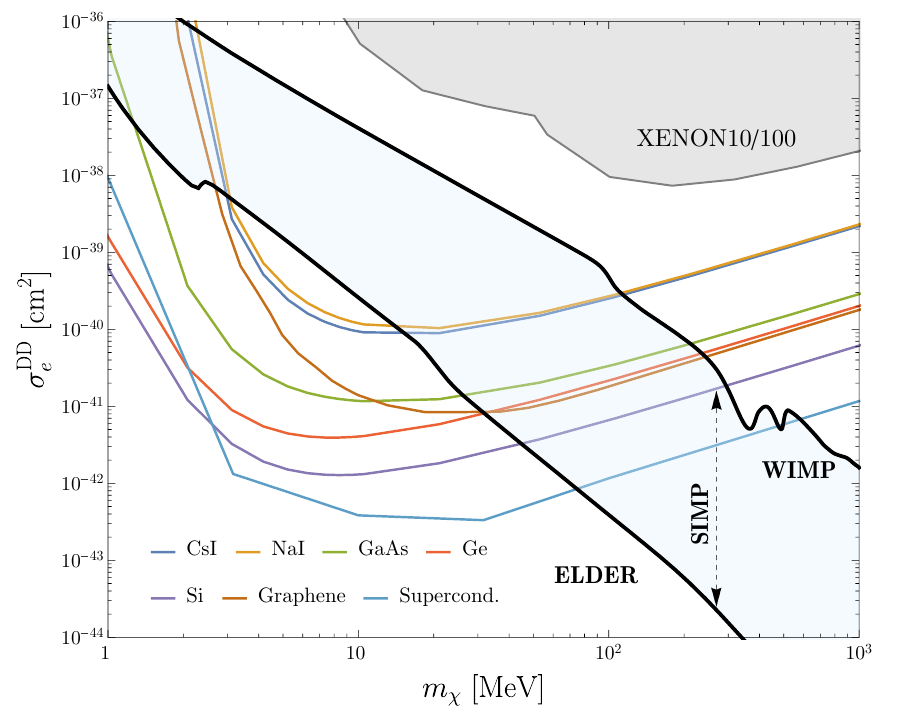
Figure 3 . Direct detection cross section, (cid:27) DD , predicted in the ELDER, WIMP and SIMP scenar- e ios with a dark photon portal. For comparison, also shown are the current bounds from XENON experiment [35, 36] and projected sensitivities for 3 events in 1 kg-year exposure of proposed exper- iments: semiconductors [37{40], superconductors (10 meV threshold) [41, 42], super(cid:13)uids [43,